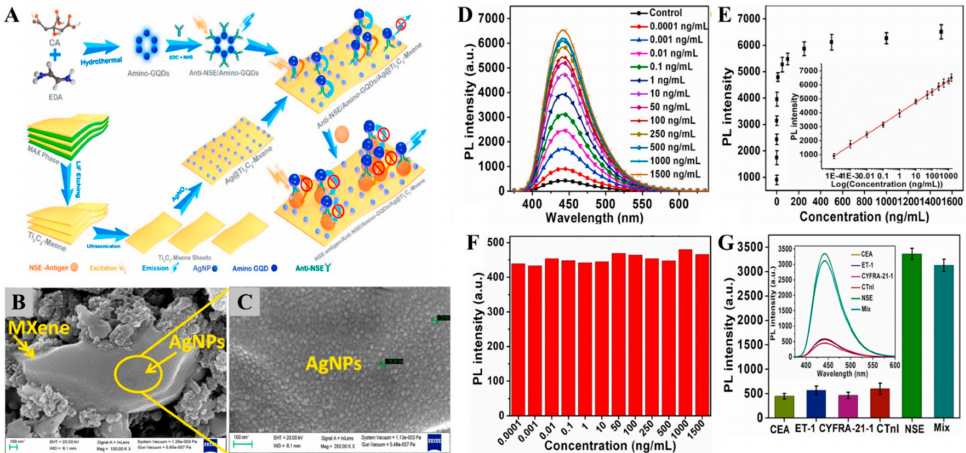
Figure 8. ( A ) Schematic illustration of the anti-NSE/amino-GQDs/Ag@Ti 3 C 2 T x based fluorometric NSE detection. ( B , C ) FE-SEM images of Ag nanoparticles decorated Ti 3 C 2 T x MXene at different magnifications. ( D ) Analytical performance of the anti-NSE/amino-GQDs/Ag@Ti 3 C 2 T x based fluorescent biosensor toward NSE detection. ( E ) Graph showing the correlation between recovered fluorescence and NSE concentration, inset shows the corresponding calibration curve between recovered fluorescence and log NSE concentration in the range of 1 × 10 − 4 –1.5 × 10 3 ng/mL. ( F ) Selectivity of the proposed biosensor. ( G ) Control experiment for the amino-GQDs/Ag@Ti 3 C 2 T x electrode. Reprinted with permission from Ref. [152]. Copyright © 2022